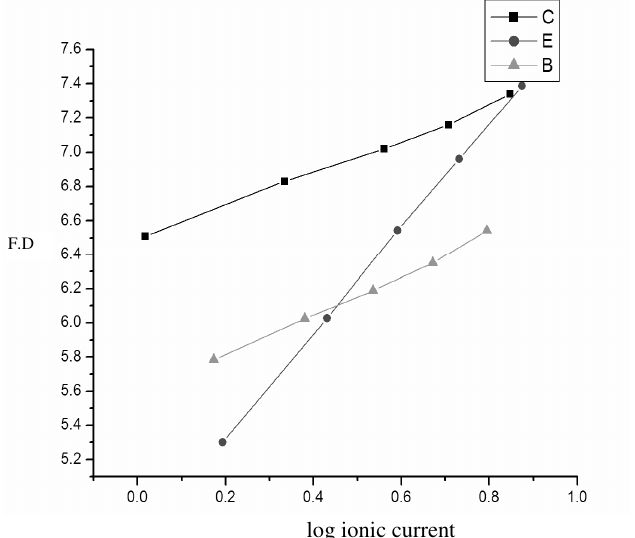
) with differential field (F.D). i